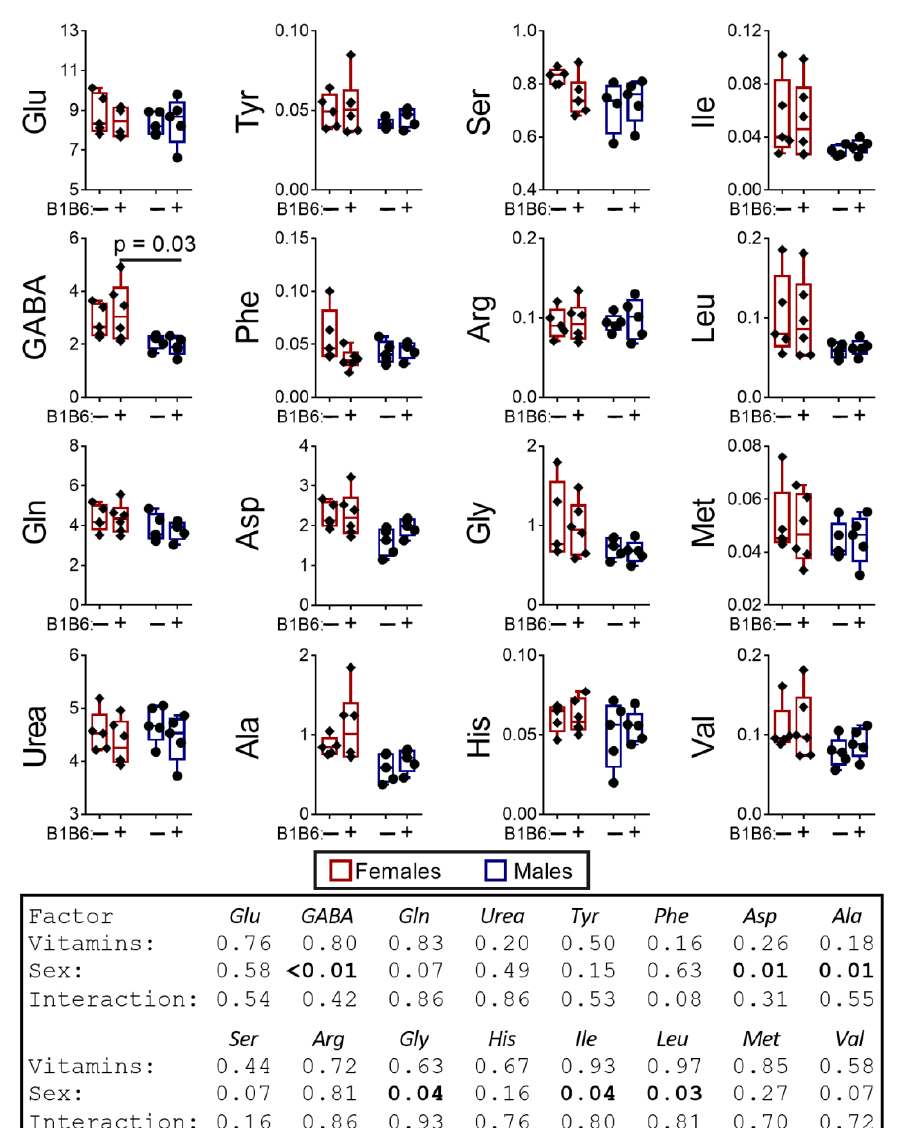
Figure 9. Effects of the administration of vitamins of B1 and B6 to the control rats on the levels of amino acids and urea in the rat brain. The content of free amino acids and urea is shown in micromoles per g of tissue. The statistical analysis of the data was performed by the two-way ANOVA with Tukey ’ s post hoc test (see Section 4).